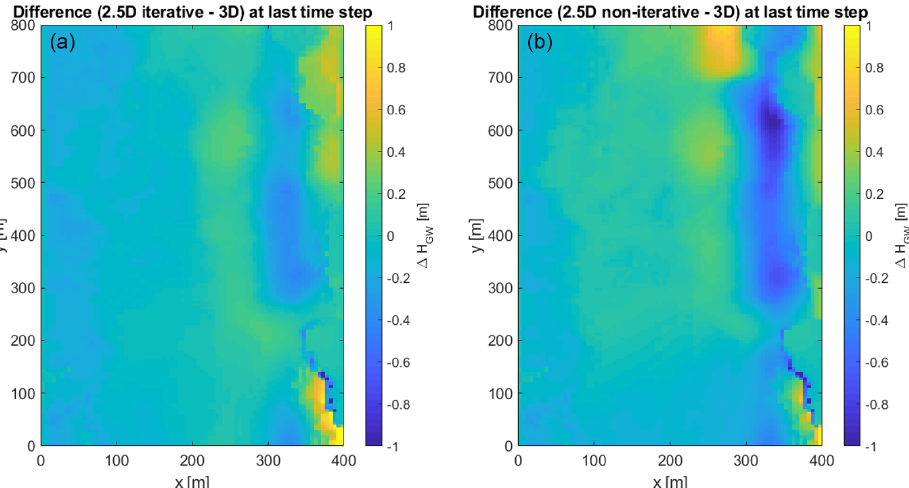
Figure 13. Difference of the groundwater table position compared to the full 3D run at the last time step. (a) Iterative coupling. (b) Non- iterative coupling.